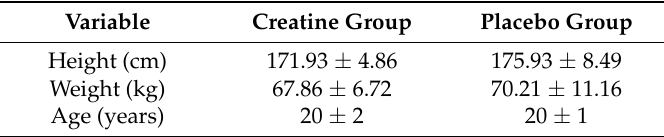
Table 1. Subject